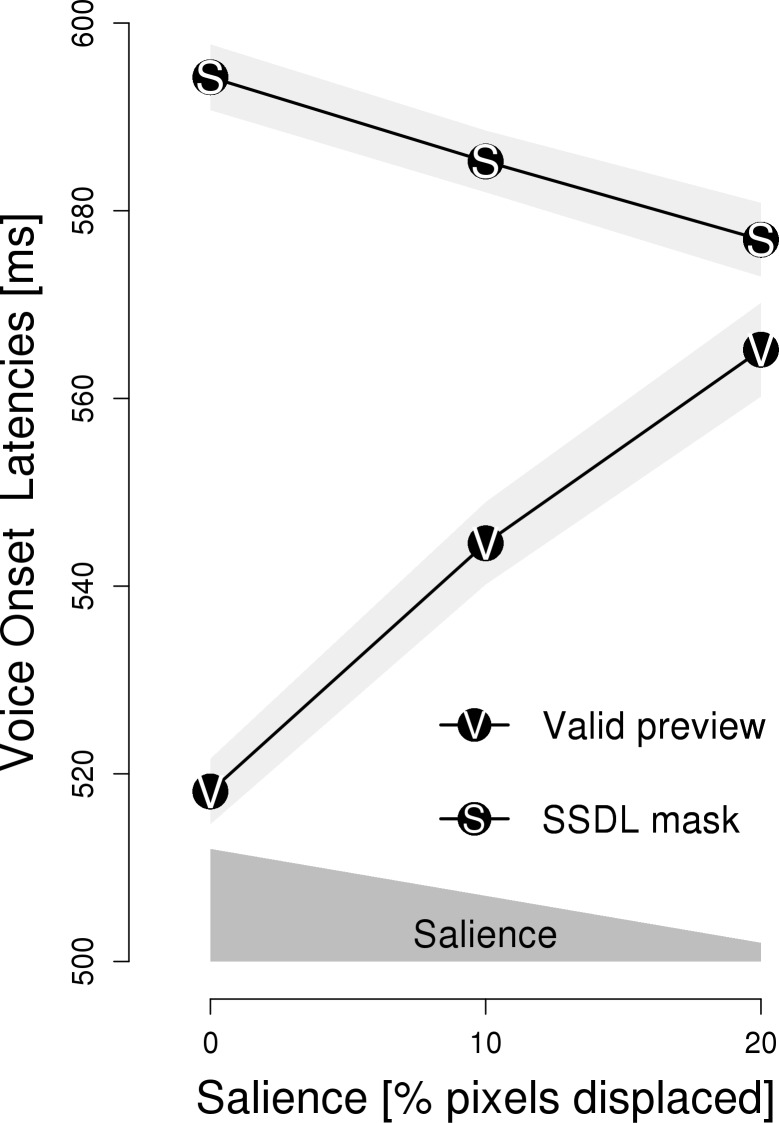
Experiment 2: Mean voice onset latency.Voice onset latencies are depicted in relation to the three levels of salience-by-perceptibility and is plotted separately for valid previews and same-shape, different letter (SSDL) masks. The light-gray areas represent 1 SEM. The dark gray polygon above the x-axis indicates the level of salience, i.e., the salience is high if the preview is visually intact (i.e., 0% of the pixels displaced), but decreases when the preview is visually degraded (i.e., when an increasing percentage of pixels is displaced).